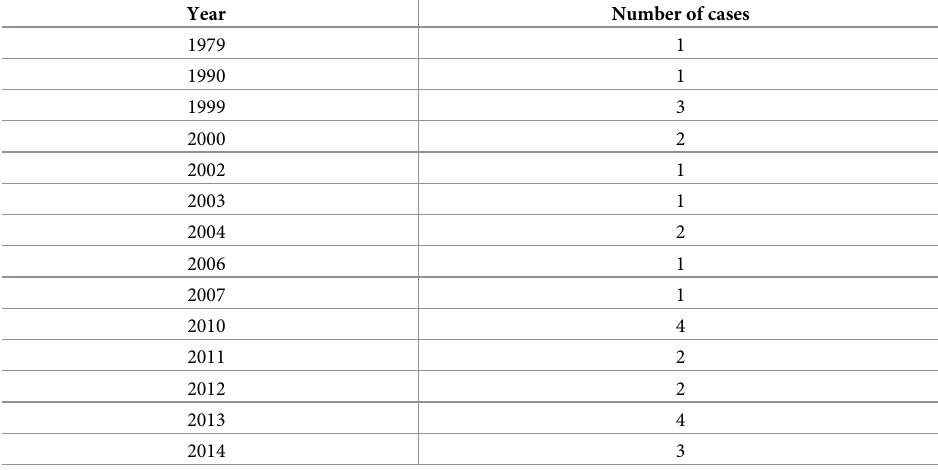
the soil nutrient levels on crop fields of households not affected by cassava cyanide intoxication in the logistic regression analysis. The results of the logistic regression analysis showing the likelihood of cassava cyanide intoxication occurring due to the soil nutrient levels of crop fields on which cassava was culti- vated are shown in Table 6. The logistic regression analysis indicated that pH and Fe were sig-